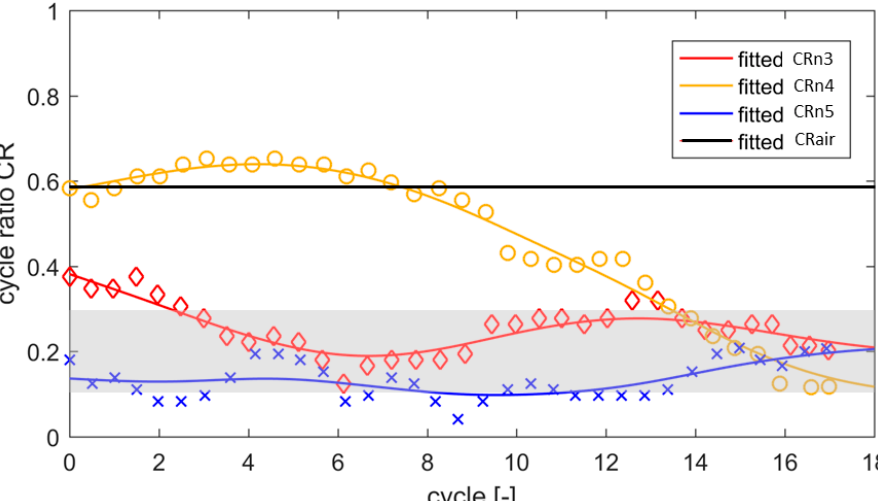
Figure 6. Evolution of the flap-to-flap phase relationship in the first 18 cycles, shown in terms of the cycle ratio CR n 3–5 between pairs of flaps 2–5. For comparison, the black line shows the behavior of one pair of flaps CR n 4 for the reference case in air. The curve fitting is done with a smoothing spline. The gray shaded region is the range of cycle ratios reported in literature for metachronal waves of ciliated walls to achieve optimum fluid transport [21].